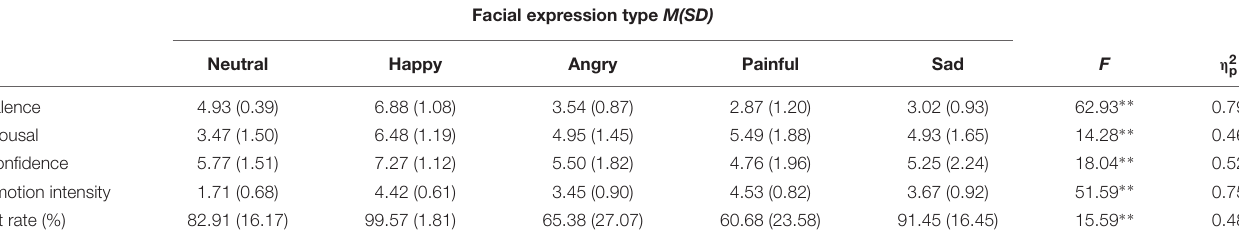
TABLE 1 | Experimental material rating results.